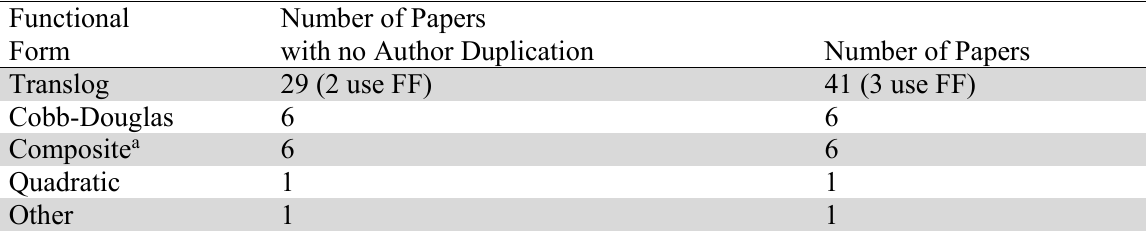
Counts of functional forms papers using a parametric method Functional Form